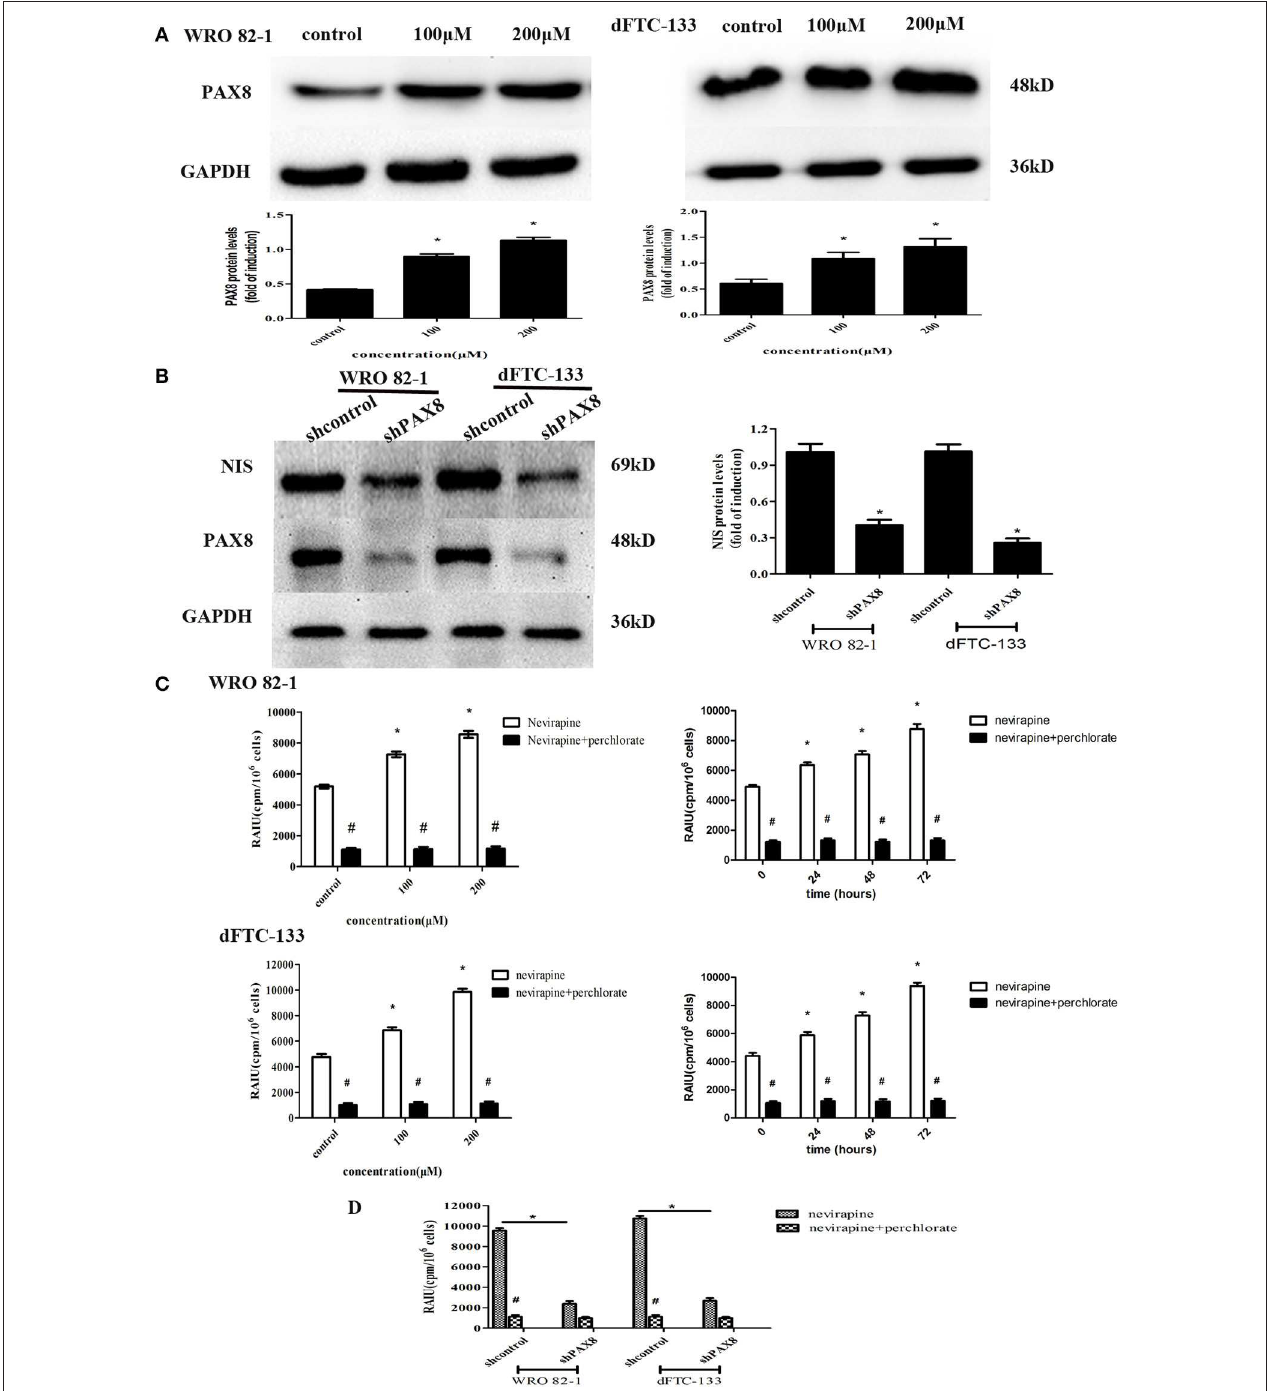
FIGURE 4 | The expression of PAX8 protein was increased by nevirapine and up-regulation of NIS and radioactivity by nevirapine was related to a PAX8 dependent mechanism. (A) WRO 82-1 and dFTC-133 cells were treated with nevirapine for 72h and subsequently PAX8 expression was determined by western blot analysis with quantitative analysis. GAPDH was used as the loading control. Data are shown as the mean ± SD of three experiments. (B) WRO 82-1 and dFTC-133 cells were transfected with sh-Control or sh-PAX8, and then treated with 200 µ M of nevirapine for 72h. The expression of NIS protein was determined by western blot analysis and analyzed quantitatively. (C) Radioactive iodine uptake (RAIU) in WRO 82-1 and dFTC-133 cells was determined. The sodium perchlorate was used as a selective inhibitor for NIS-mediated iodide uptake. (D) WRO 82-1 and dFTC-133 cells were transfected with sh-Control or sh-PAX8, and then RAIU was determined with or without sodium perchlorate. * P < 0.05 vs. control, # P < 0.05 vs. relevant group treated by nevirapine only.